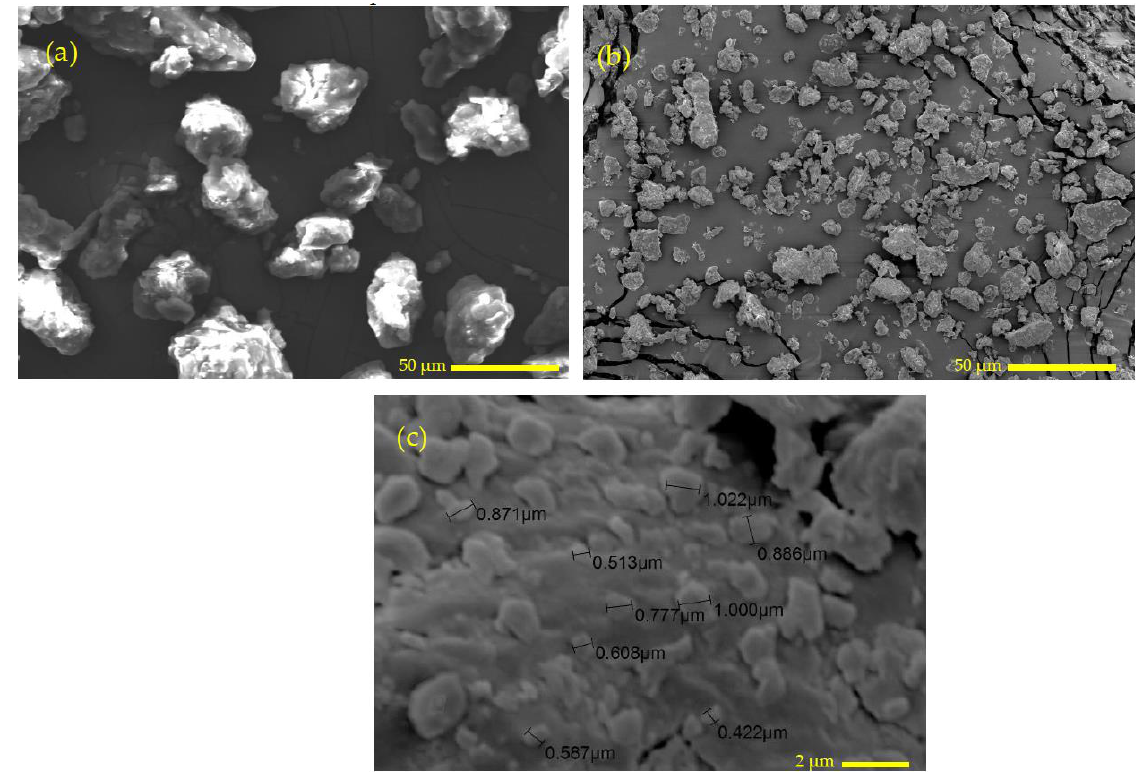
Figure 4. SEM image of date pit particles ( a ) after the grain milling process and ( b,c ) after the ball milling process.